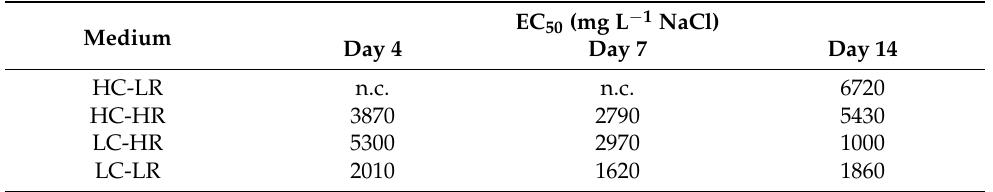
Figure 1. Growth of control and NaCl-treated Coelastrum morus cultures in: ( a ) HC-LR; ( b ) HC-HR; ( c ) LC-HR and ( d ) LC-LR media based on coenobia numbers. HC: higher content; LC: lower content; HR: higher ratio; LR: lower ratio. Mean values ( n = 3) and standard deviations are plotted. 500; 1000; 5000 and 10,000: NaCl concentrations in mg L − 1 . Significant differences ( p < 0.05) among growth curve tendencies are indicated by different lowercase letters. Lowercase letters with asterisks show partial significant difference when it cannot be marked by a different letter. Table 3. NaCl concentrations causing 50% growth inhibition in media with different nutrient concentrations and N:P ratios.